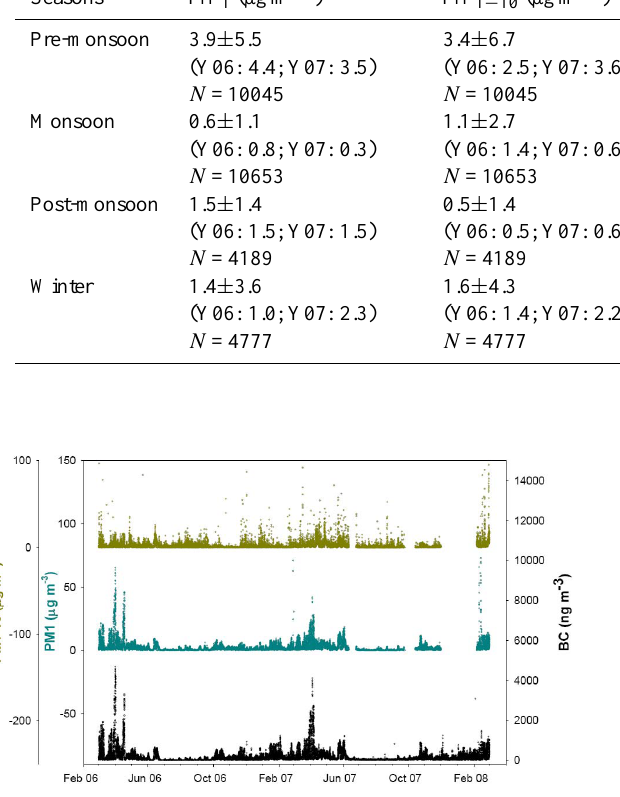
Fig. 1. Time series of 30-min averaged BC (black), PM 1 (cyan) and PM 1 − 10 (brown) at Figure 1. Time series of 30-min averaged BC (black), PM1 (cyan) and PM1-10 (brown) at NCO-P